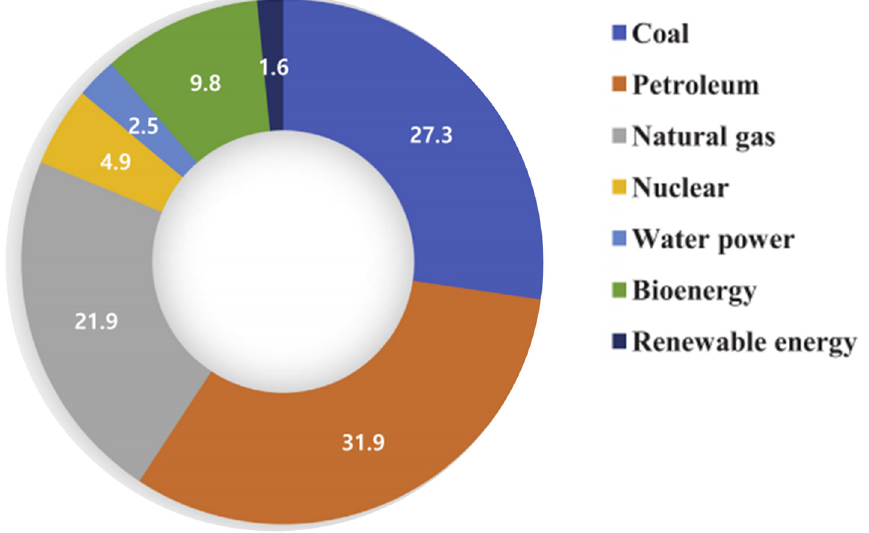
Figure 1. World demand forecast by primary energy source. Adapted with permission from [6]. Copyright, 2019 Elsevier.